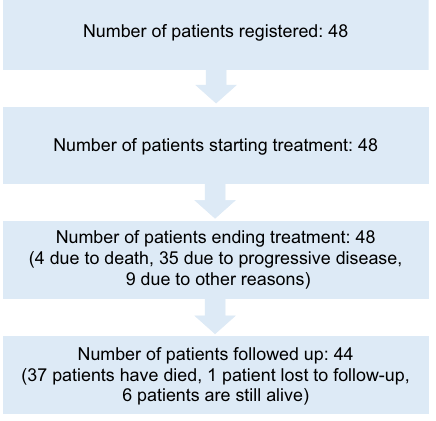
Figure 1. Study flow.